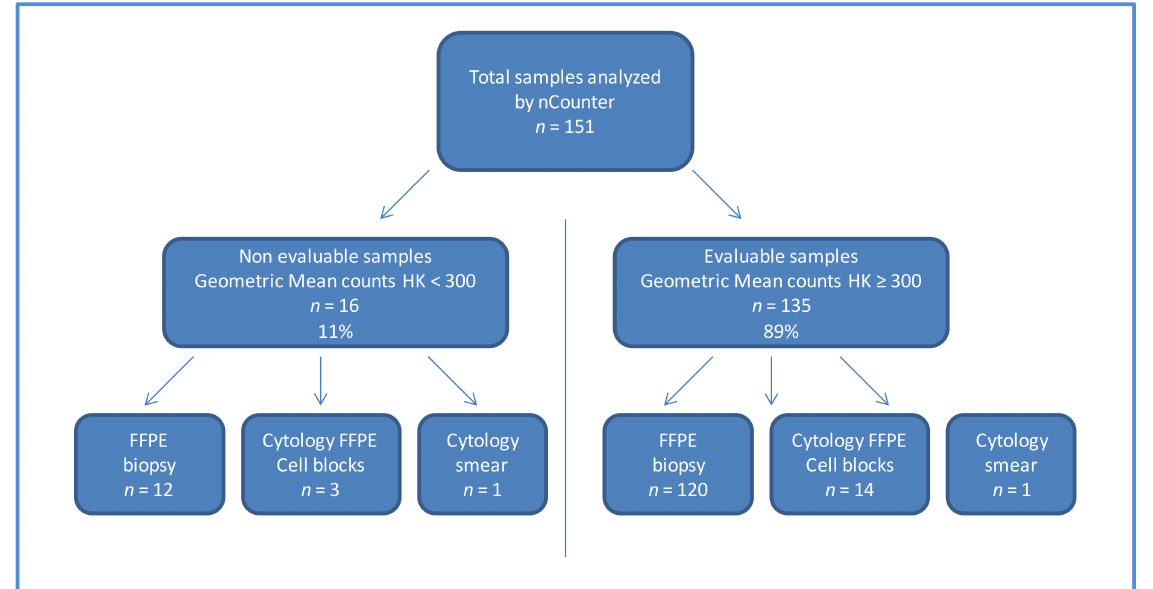
Figure 1. Flow chart of the samples included in the study. Abbreviation: FFPE: formalin-fixed paraffin-embedded HK: housekeeping.